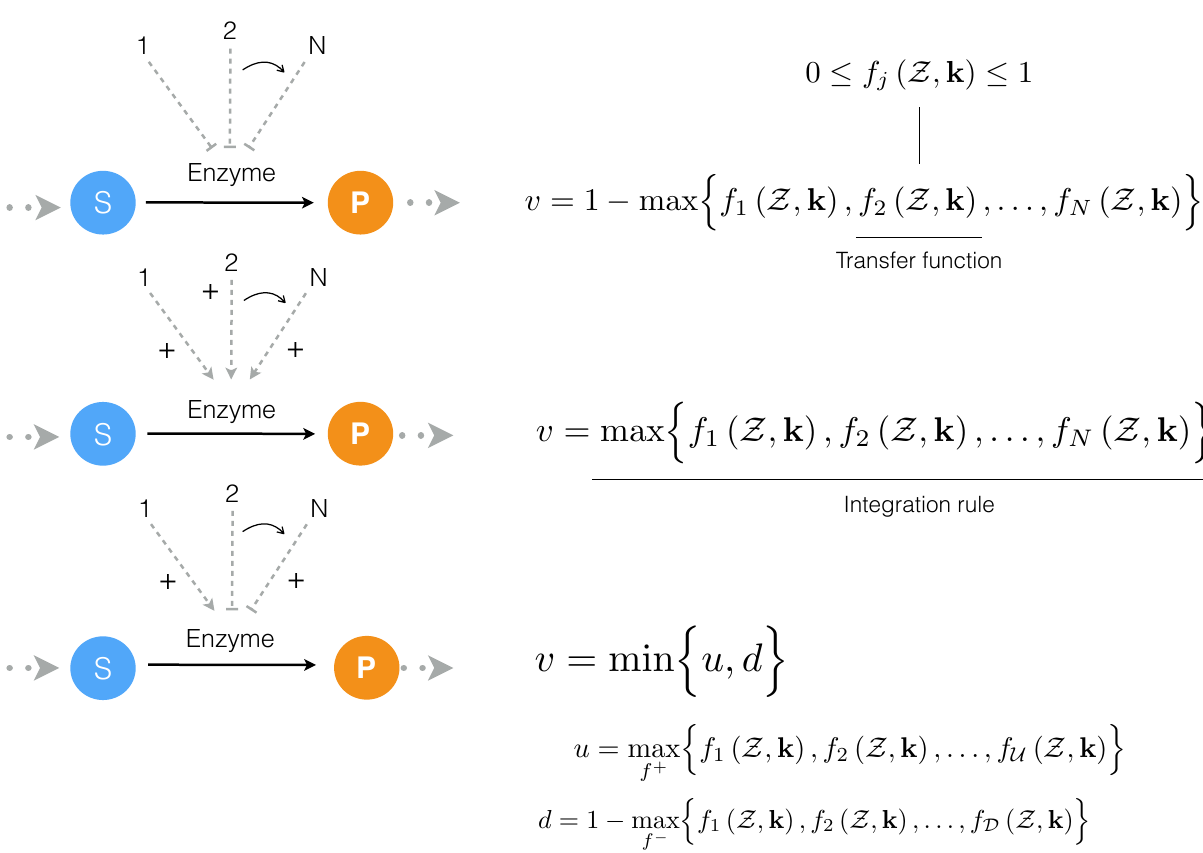
Figure 2. Schematic of rule-based effective control laws. Traditional enzyme kinetic expressions, e.g., Michaelis-Menten or multiple saturation kinetics are multiplied by an enzyme activity control variable 0